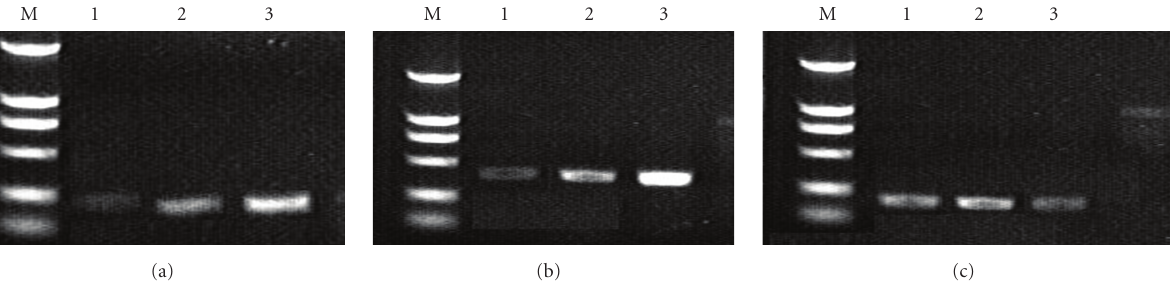
Figure 1: RT-PCR results for MMP-1(A), TIMP-1(B), and β -actin(C): M , marker, lane 1, normal controls; lane 2, M group; lane 3, MTS